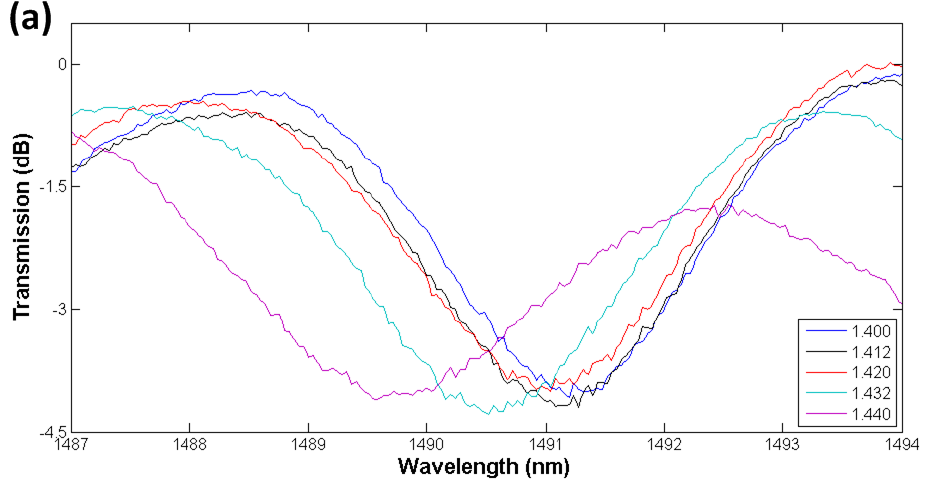
Figure 5. Resonant wavelength. (a) spectrums and (b) dips shift in response to the increase of refractive